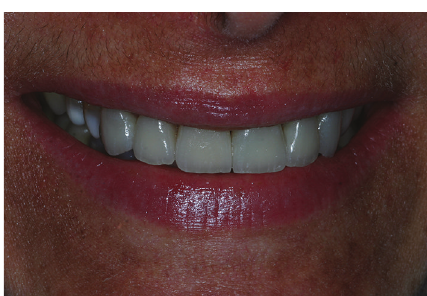
Figure 16: Final clinical result.